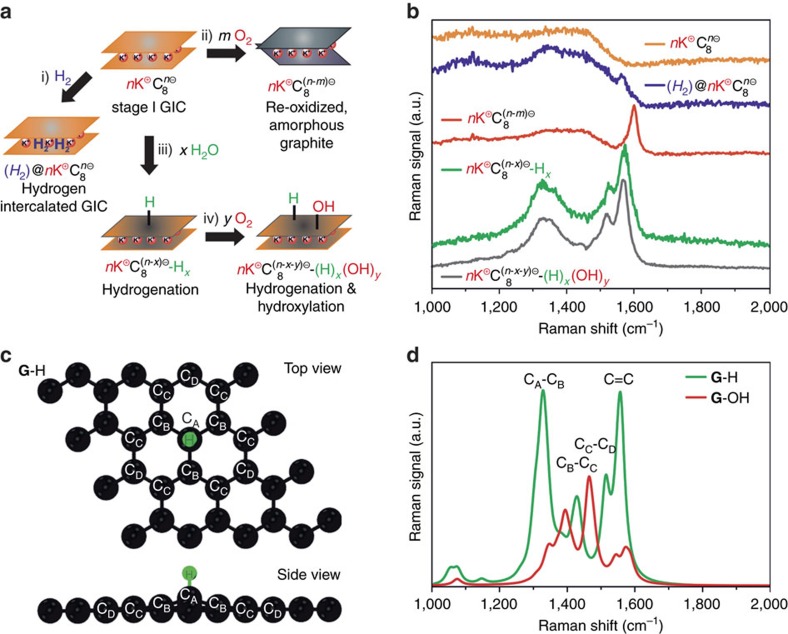
Identification and assignment of new Raman bands in G-H.(a) Systematic study of KC8 exposed to (i) hydrogen, (ii) oxygen and (iii) water that was subsequently exposed to (iv) oxygen. The corresponding in situ Raman spectra are shown in b. Starting from saturation doped KC8, (i) H2 leads to intercalation, (ii) O2 to reoxidation to amorphous graphite and (iii) H2O to sp3 defect site formation by hydrogenation. If (iv) O2 is added in combination with H2O, also hydroxylation takes placed. (c) 4 × 4 supercell of 32 lattice carbon atoms with a sp3 C-H moiety attached to carbon atom CA and the directly neighbouring labelled lattice carbon atoms CB and CC. Reference supercells for defect-free graphene G: see Supplementary Fig. 5; supercells for hydroxylated G-OH: see Supplementary Fig. 6. (d) The calculated Raman spectra between 1,000 and 2,000 cm−1 with one hydrogenated/hydroxylated sp3 carbon atom in a cell of 32 graphene lattice carbon atoms, respectively. For the detailed information on vibrational frequencies and a visualization of the modes see Supplementary Tables 1 and 2.